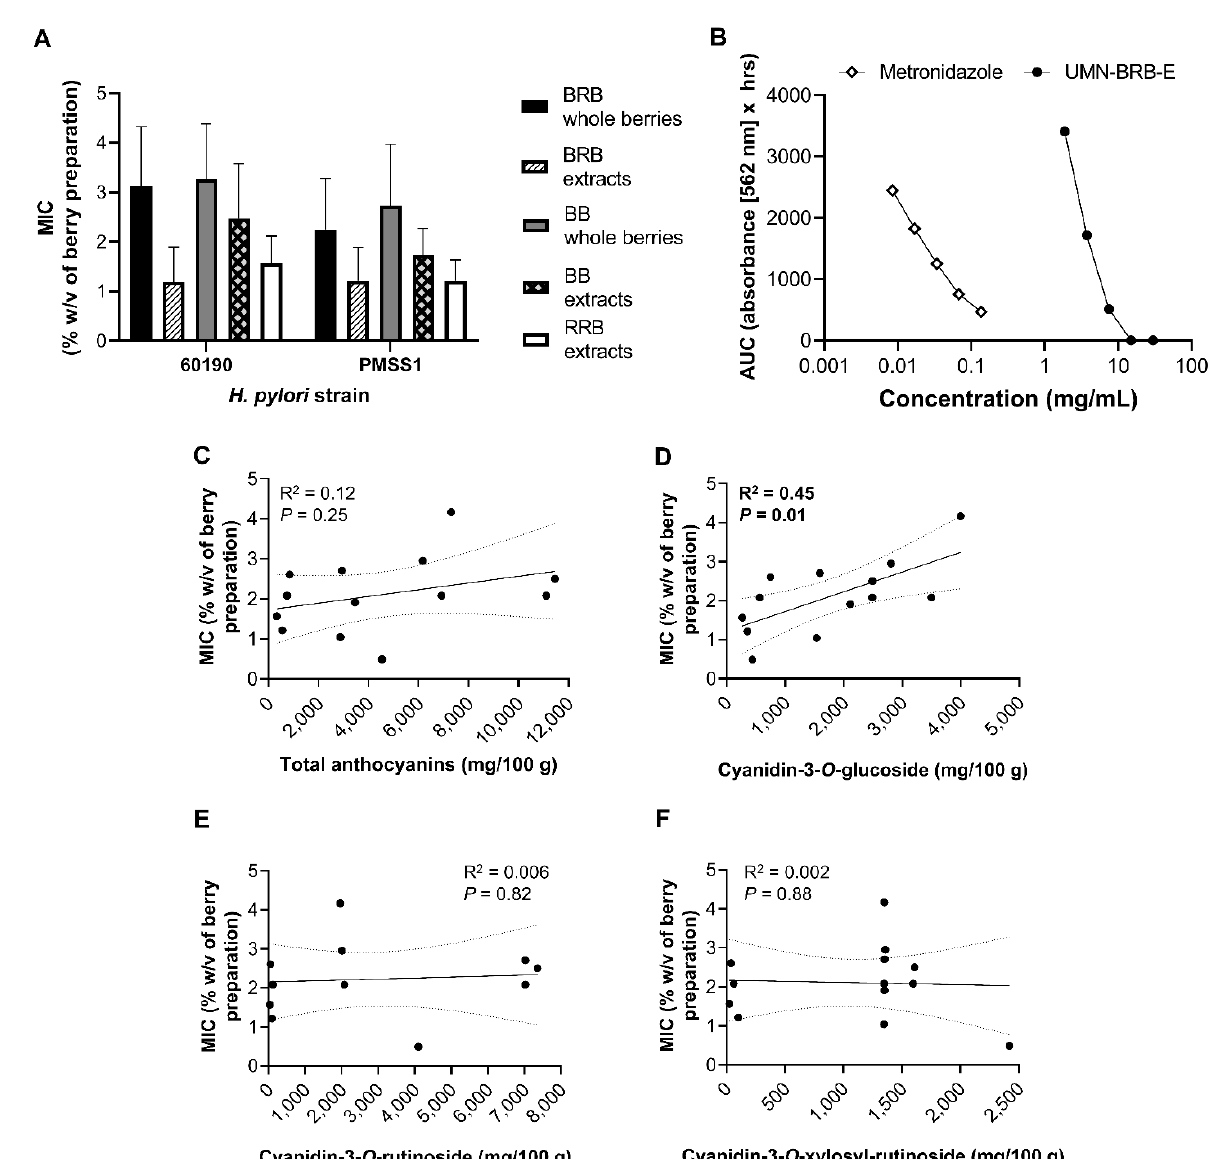
Figure 6. Minimum inhibitory concentrations (MICs) of berry preparations for antibacterial activities against H. pylori . ( A ) MIC means ± SD for different berry types and preparations against H. pylori strains 60190 and PMSS1. ( B ) Side-by-side comparison of inhibitory effects of metronidazole and H. pylori strain 60190; data representative of n = 2 independent experiments. ( C – F ) Correlation between mean MIC observed with both H. pylori strains and concentrations of ( C ) total anthocyanins, ( D ) cyanidin-3- O -glucoside, ( E ) cyanidin-3- O -rutinoside and ( F ) cyanidin-3- O -xylosylrutinoside for all berry preparations analyzed. R 2 = Pearson’s correlation coefficient.